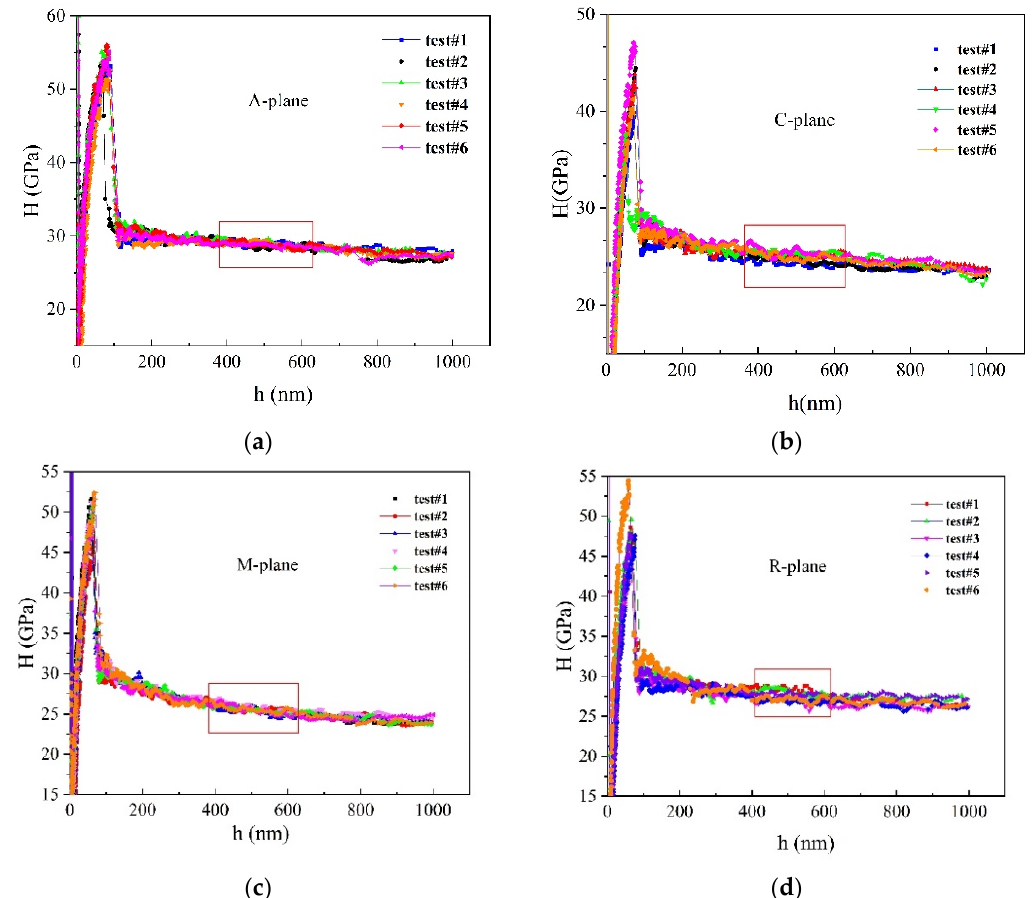
Figure 3. The hardness as a function of the indentation depth of the four crystal orientations for the ( a ) A-plane, ( b ) C-plane, ( c ) M-plane and ( d ) R-plane.